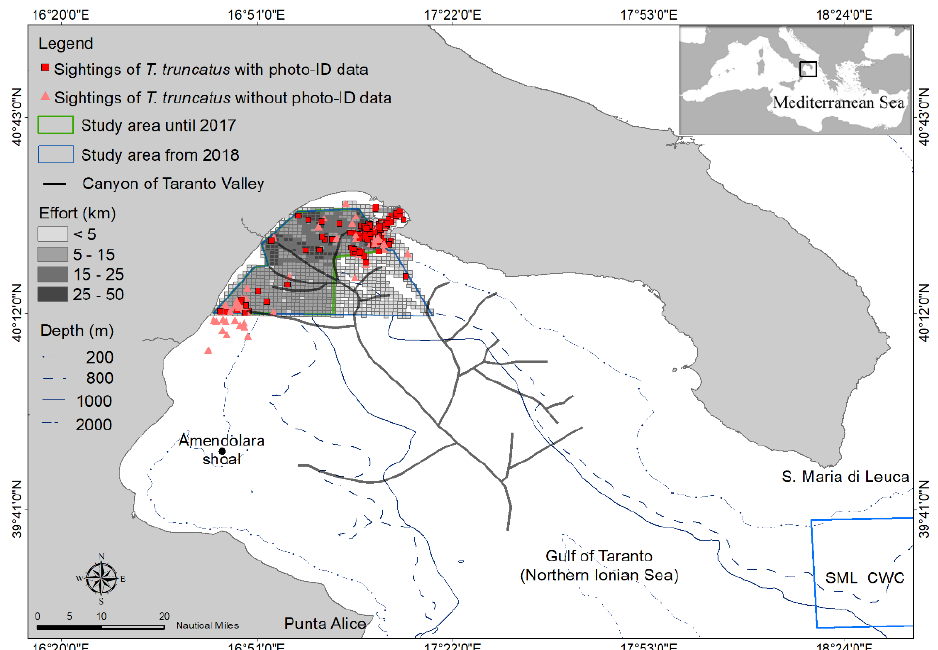
Figure 1. Map of the Gulf of Taranto with indication of its morphologic characters and evaluable habitats (Santa Maria di Luca cold–water coral, SML CWC and Amendolara shoal), surveyed areas and sightings carried out during this study period and the effort sustained (in term of km travelled) linked to sightings of T. truncatus .